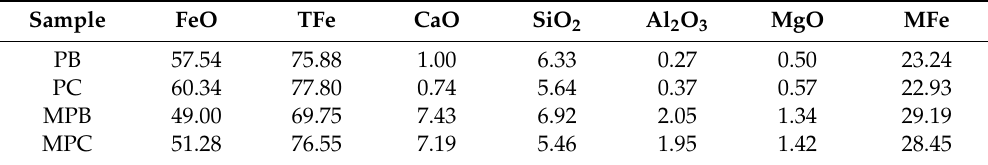
Table 3. The chemical compositions of the sample at the melting start temperature (wt%).